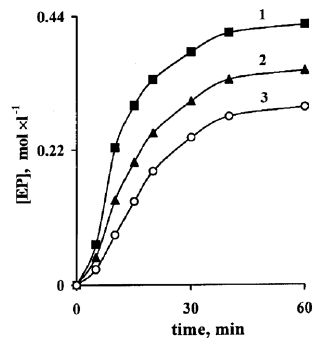
Figure 5: The kinetic curves for the oxygen consumption in the reaction of oxidation of 1-octene with molecular oxygen at 80 o C in the presence of (1) Ag/MoO and (2) MoO as well as (3) in the absence of 3 3 catalyst. The amounts of reactants and catalysts: 1.4 mL (8.75 mmol) of 1-octene, 0.01 mL (0.10 mmol) of TBHP, 0.59 mL of chlorobenzene, 0.0012 g of